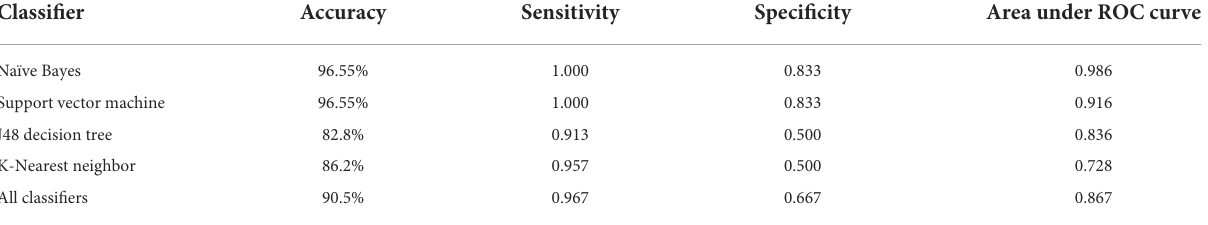
TABLE 3 Summary statistics for all four classification